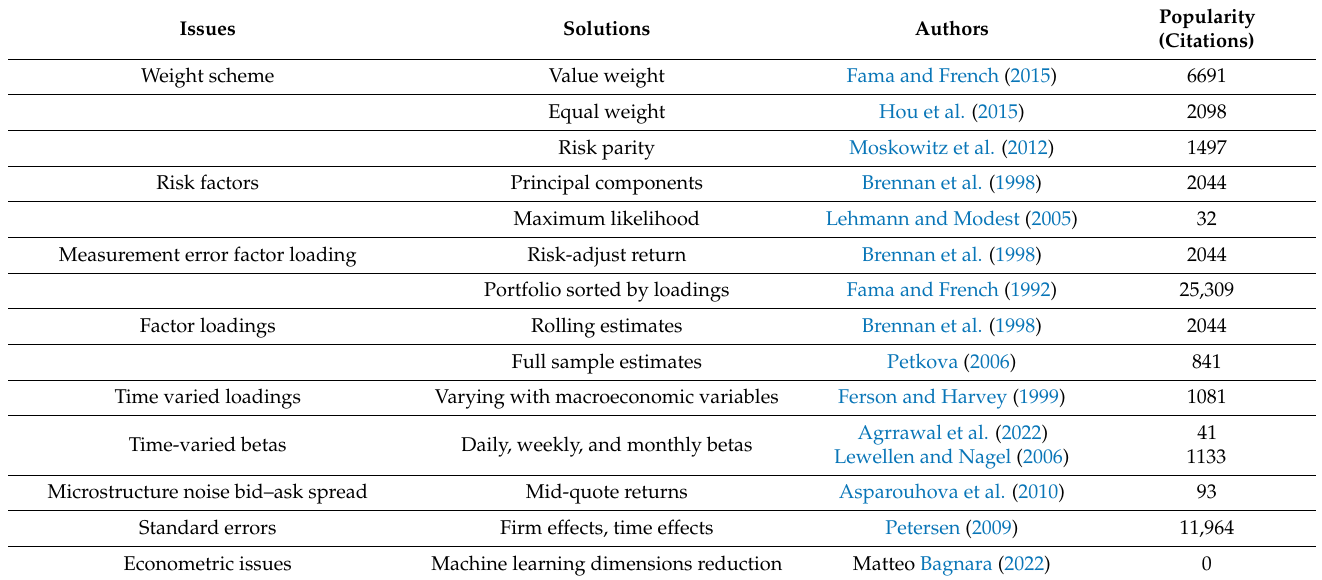
Table 2. Method issues and